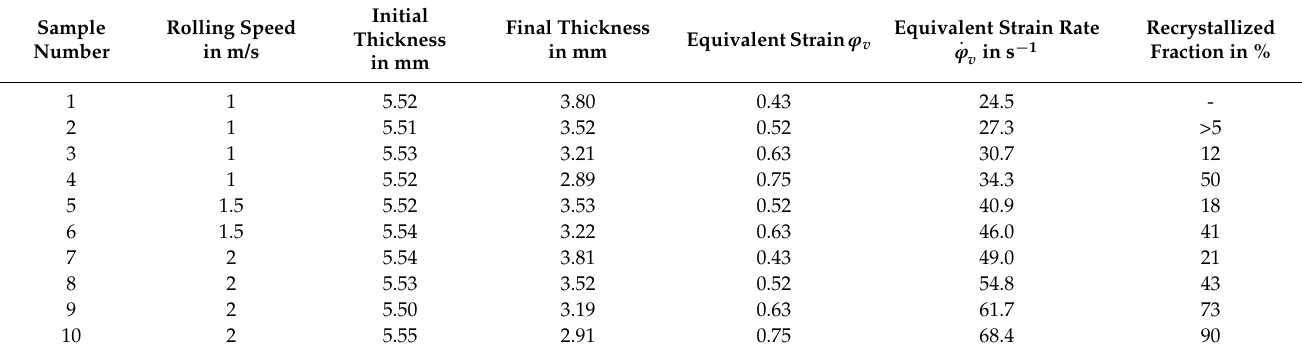
Table 3. Results of hot rolling of the twin-roll cast WZ73 sheets (initial thickness: 5.5